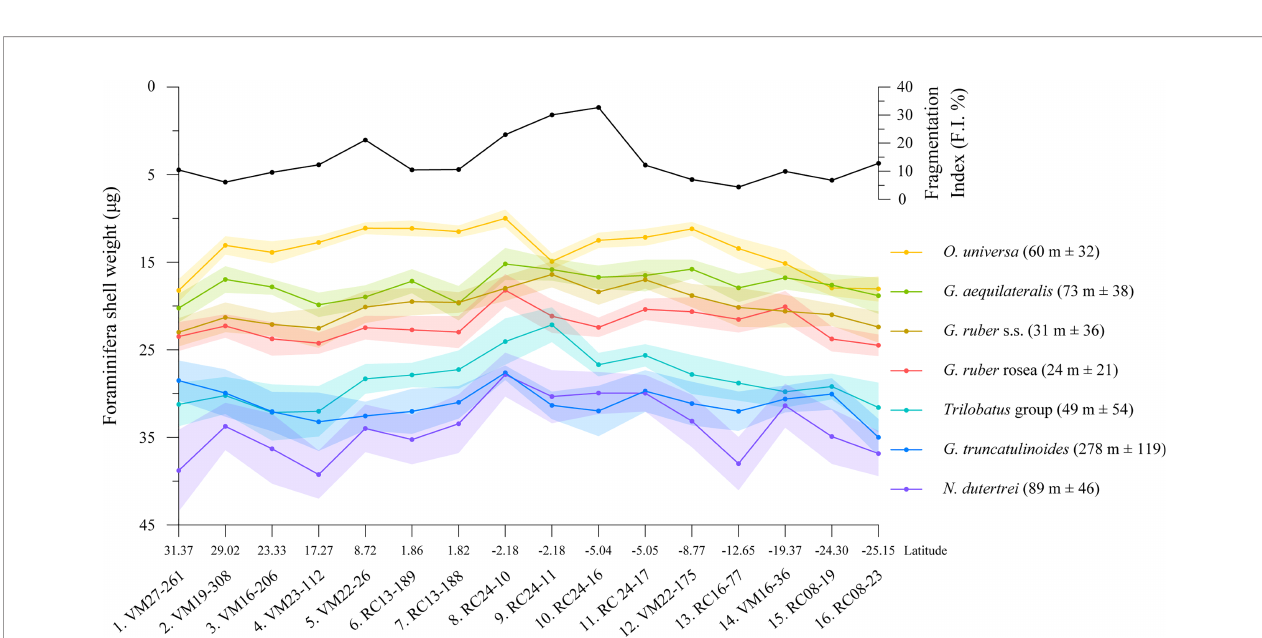
FIGURE 4 | Average sieve-based shell weights of 7 planktic foraminifera species along the studied latitudinal transect together with the shell Fragmentation Index that was counted in the fi ne sand fraction (>150 m m) of the samples. Due to weigh similarity, T. trilobus and T. sacculifer were averaged together and are referred to as Trilobatus group. The shaded areas depict the 1 s con fi dence interval of the shell weight measurements. Numbers in the parentheses to the right show the range of preferential habitat depths for each species in the region from the literature (Anand et al., 2003; Cle ́ roux et al., 2007; Farmer et al., 2007; Steph et al., 2009; Rebotim et al., 2016; Venancio et al., 2017; Lessa et al., 2019; Rebotim et al., 2019).